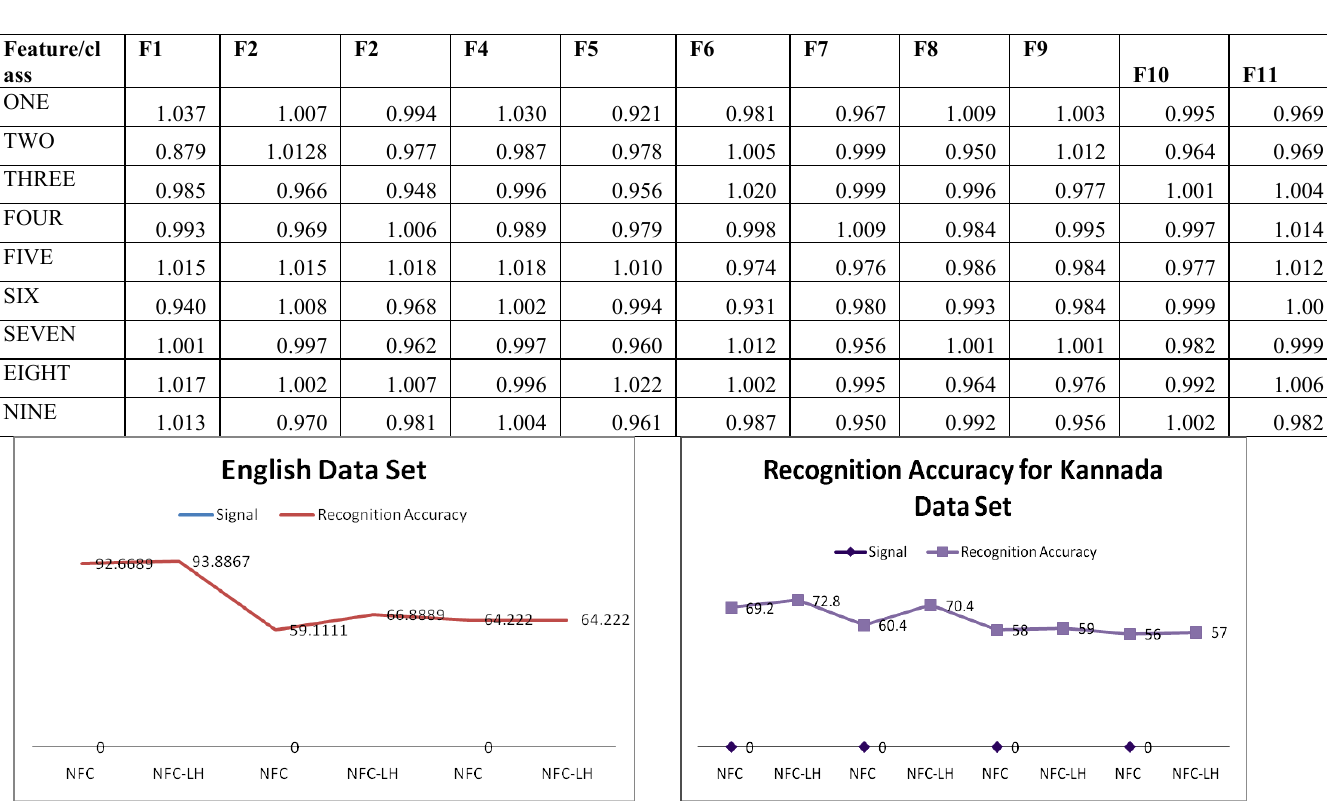
Table 4. Linguistic Hedges Values for each Class